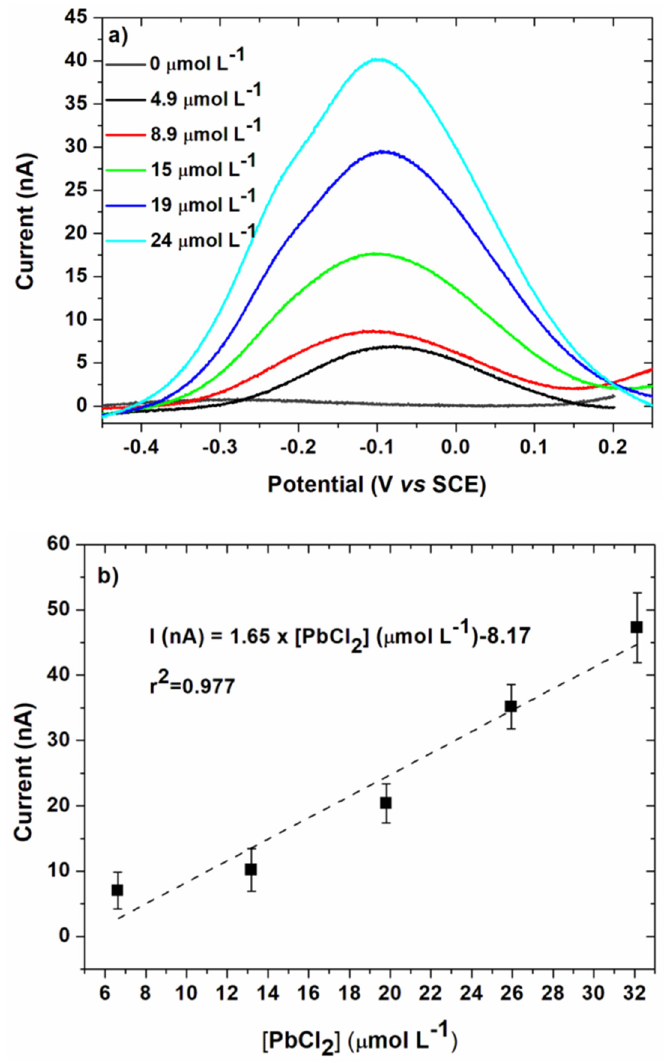
Figure 11. ( a ) Linear voltammetry obtained after substraction of the baseline for the same conditions as Figure 10 (100 mV s − 1 ); ( b ) Corresponding calibration curve in 0.1 mol L − 1 NaCl. Electrodeposition was performed at E d = − 0.5 V/SCE, t d = 90 s. Error bars are based on 3 measurements.